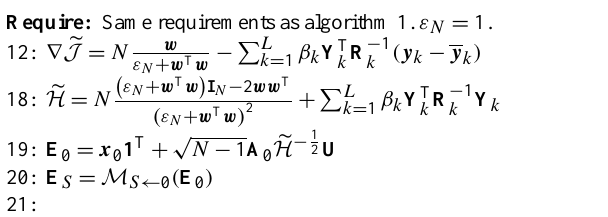
Fig. 3. Comparison of the filtering (left) and smoothing (right) performance of the SDA IEnKS, MDA IEnKS, the EnKS and 4D-Var, in weakly non-linear conditions corresponding to ∆ t = 0 . 05 . Algorithm 2 A cycle of the lag-L / shift-S / MDA / bundle / Gauss-Newton IEnKS-N. Same as algorithm 1 with the ex- ception of the following